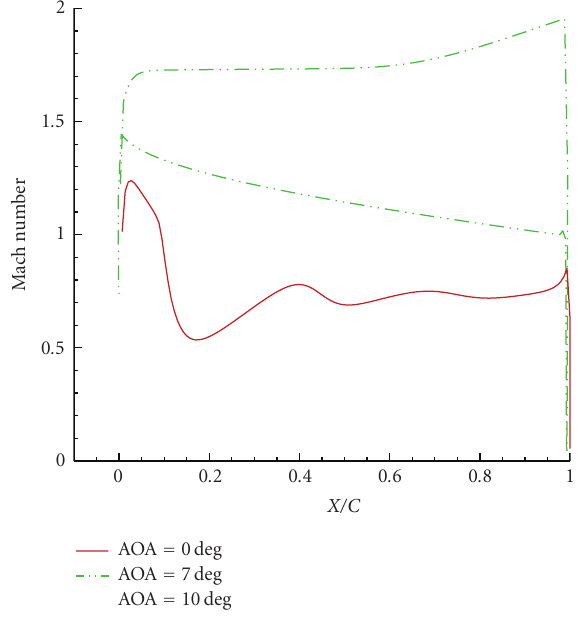
Figure 9: Mach no. profile of HTPB surface at di ff erent AOA (C: length of the HTPB slab).